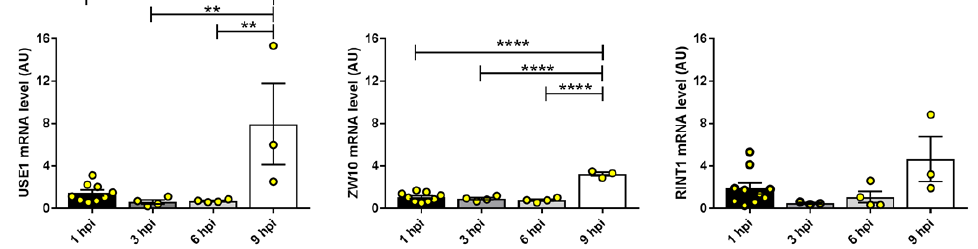
Figure 5. Gene expression analysis of components of the syntaxin 18 complex known to interact with NBAS during SARS-CoV-2 infection of Calu3 cells. Each bar represents the mean of at least four technical replicates ± standard error of the mean (SEM); analysis of the outliers was performed using the ROUT method and Q = 1%. ** p < 0.01, **** p < 0.0001. One-way ANOVA with the Bonferroni multiple comparison test.